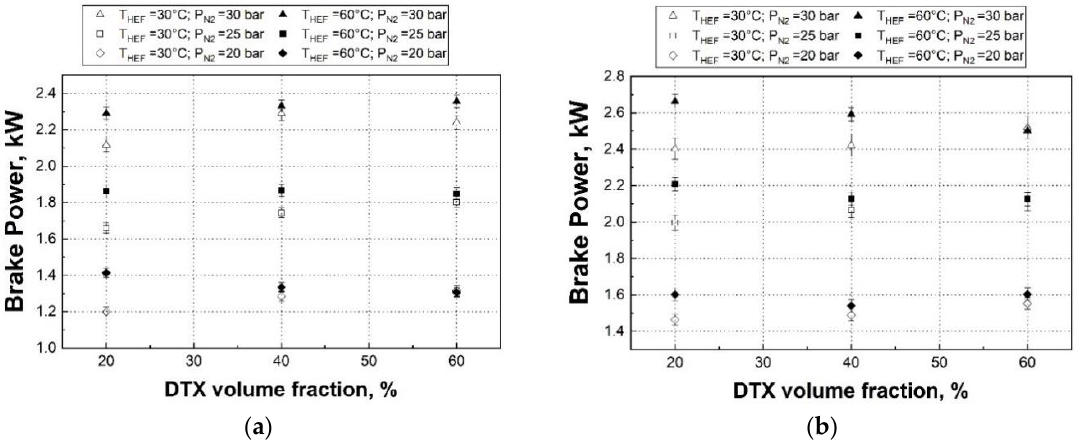
Figure 6. Comparison between experimental and modelled indicated power at different operation conditions: ( a ) 𝑁 =